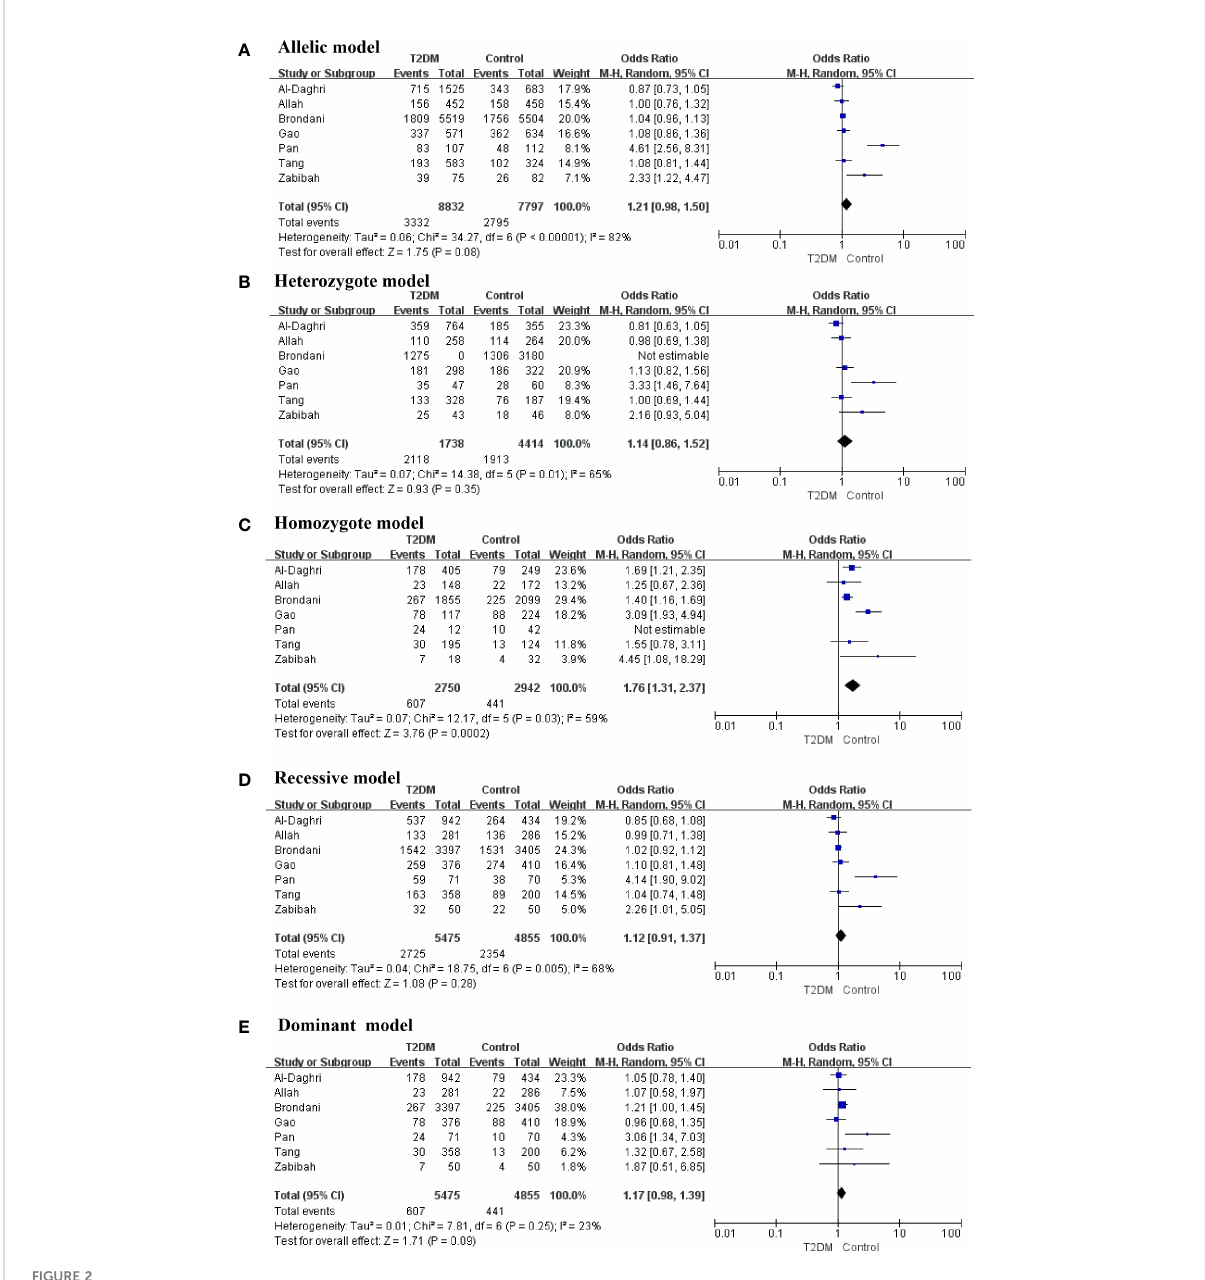
FIGURE 2 Forest plots of the polymorphism of rs3480 and the T2DM risk under fi ve genetic models (A-E)